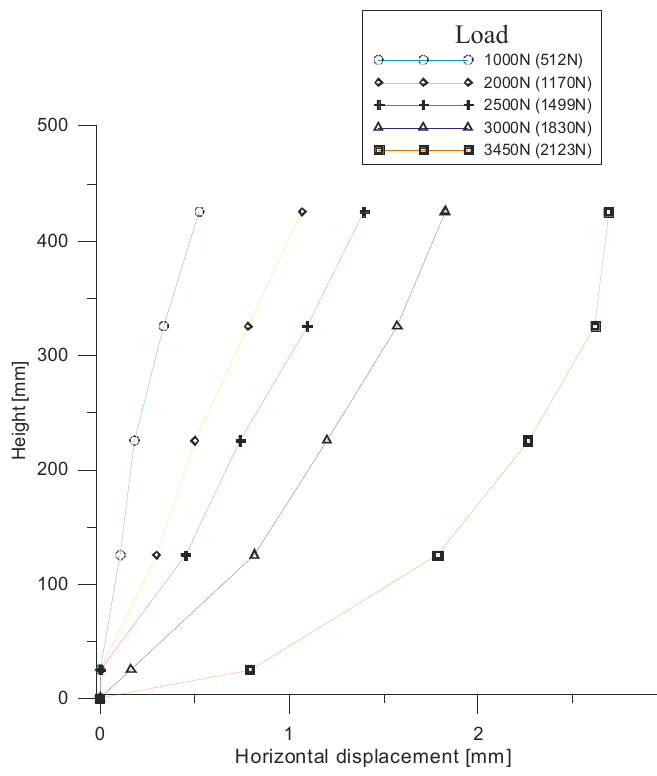
Figure 8. Horizontal deformation of the facing recorded at different loading levels.